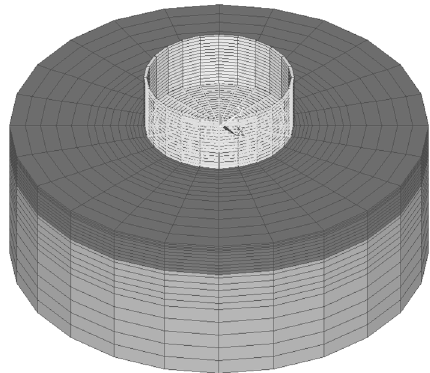
Fig. 1. Model of the cylindrical tank and the subsoil